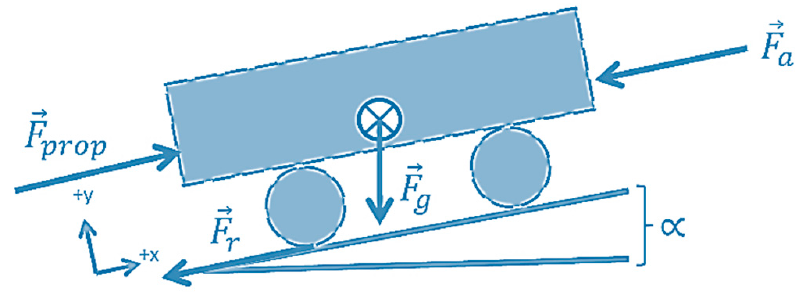
Figure 4. Free body diagram of the bus in motion.